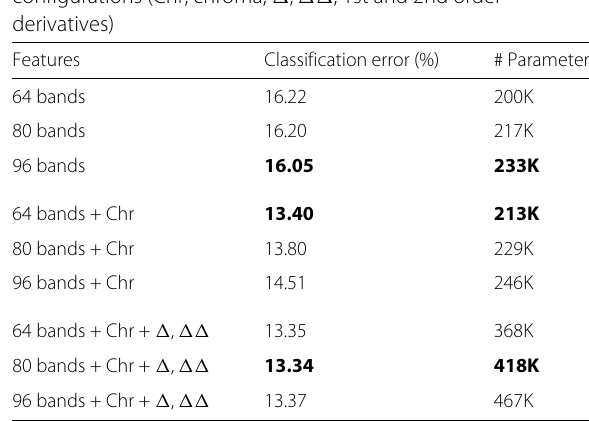
Table 1 Classification error with oracle boundaries for the 1BLSTM RNN classifier on the test partition for different frontend configurations (Chr, chroma; (cid:4) , (cid:4)(cid:4) , 1st and 2nd order